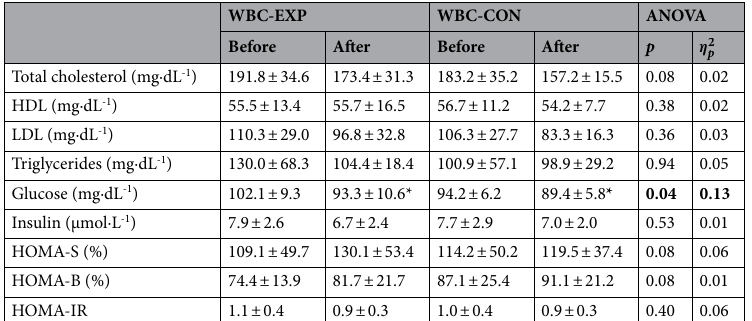
Table 3. The effect of chronic whole-body cryotherapy on lipid profile and glucose homeostasis indicators among WBC-EXP (n = 22) and WBC-CON (n = 13). Data are presented as mean ± SD; *statistically significant difference between before and after measurements in the group, p < 0.05; η squared): ≥ 0.01 small, ≥ 0.06 medium and ≥ 0.14 large effect; HDL: high density lipoprotein; LDL: low density lipoprotein; HOMA: The Homeostasis Model Assessment estimates: HOMA-B- β-cell function; HOMA-S: insulin sensitivity as percentages of a normal reference population and HOMA-IR: insulin resistance. Statistically significant group x time interaction are bold.